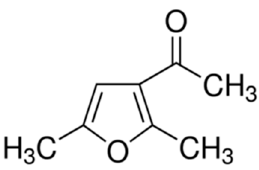
Figure 3. Structural formula of DMF.